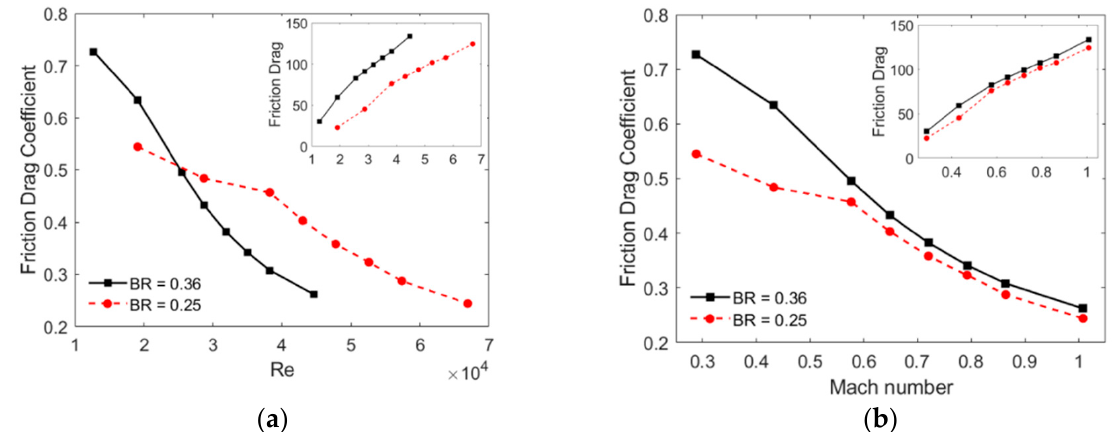
Figure A2. Variation of friction drag coefficients on blockage ratio and ( a ) Re, ( b ) Mach number. Insets represent the variation of drag.